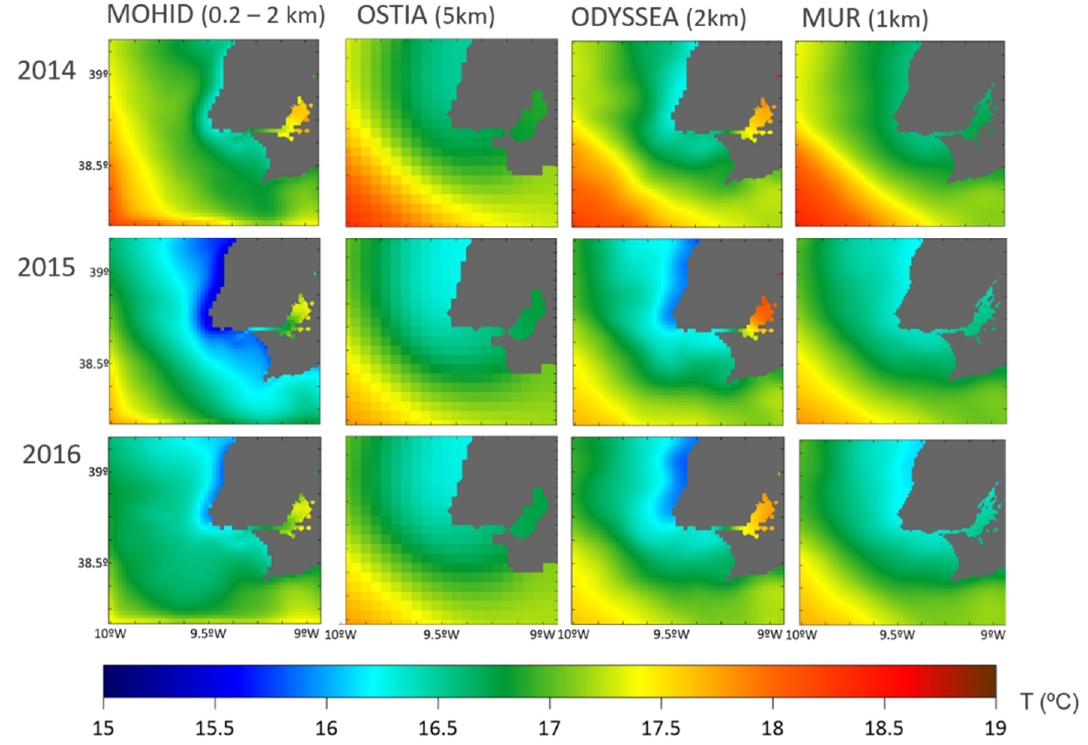
Figure 8. Interannual comparison of surface seawater temperature between MOHID and Satellite L4 gridded products (OSTIA-5km, ODYSSEA-2 km; and MUR 1 km) for the period 2014–2016.